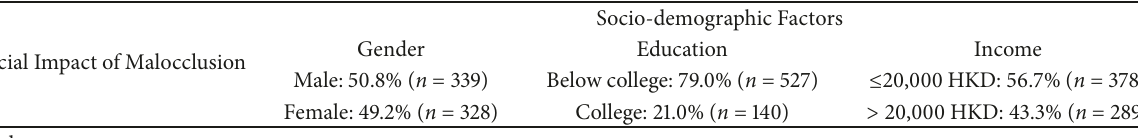
Psychosocial Impact of